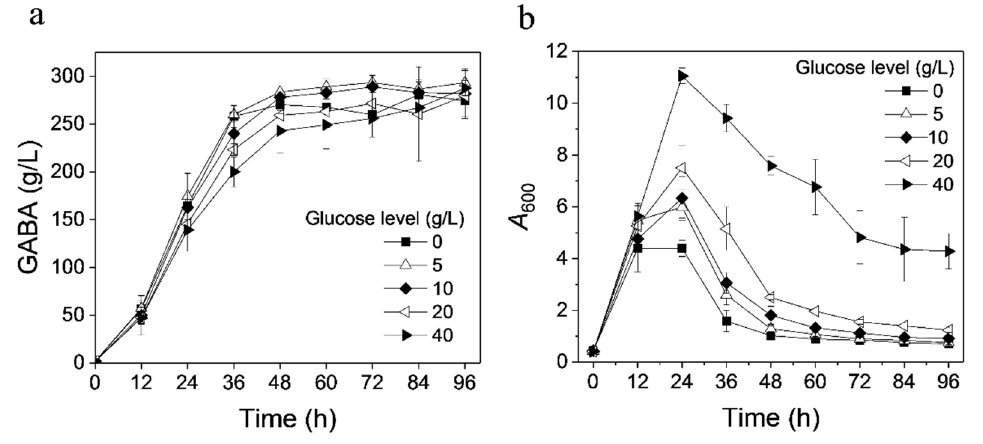
Figure 1. The effect of glucose on ( a ) GABA production and ( b ) cell growth. This was evaluated using a 250 mL Erlenmeyer fermentation flask at 32.0 °C. Cell growth was expressed as A 600 . Vertical bars represent standard deviations of means ( n = 3). There was no significant difference in the 48 h GABA concentration of the tested glucose levels ( p = 0.084). GABA, gamma-aminobutyric acid; A 600 , absorbance at 600 nm.